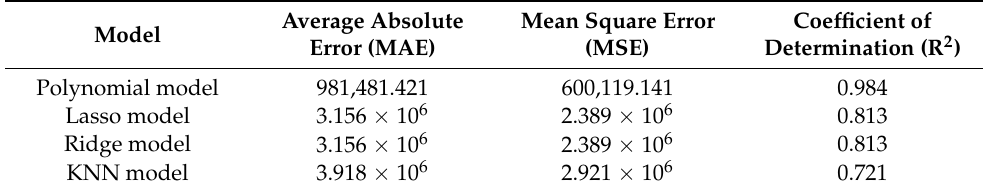
Table 4. Comparison of four regression models.